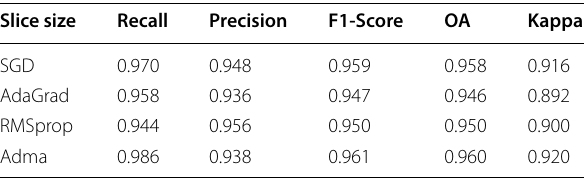
Table 2 Evaluation of the proposed model with the different slice sizes on dataset 2 Slice size Recall